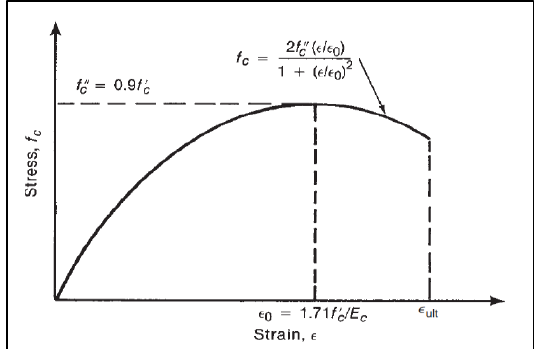
Fig. 3. Todeschini model for compression behavior of concrete [4].